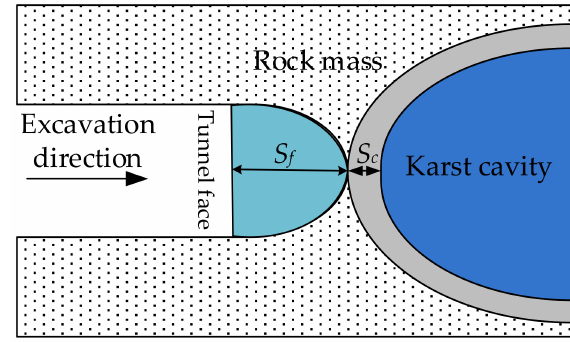
Figure 6. Sketch of minimum safe thickness of water-resistant strata ahead of karst tunnel